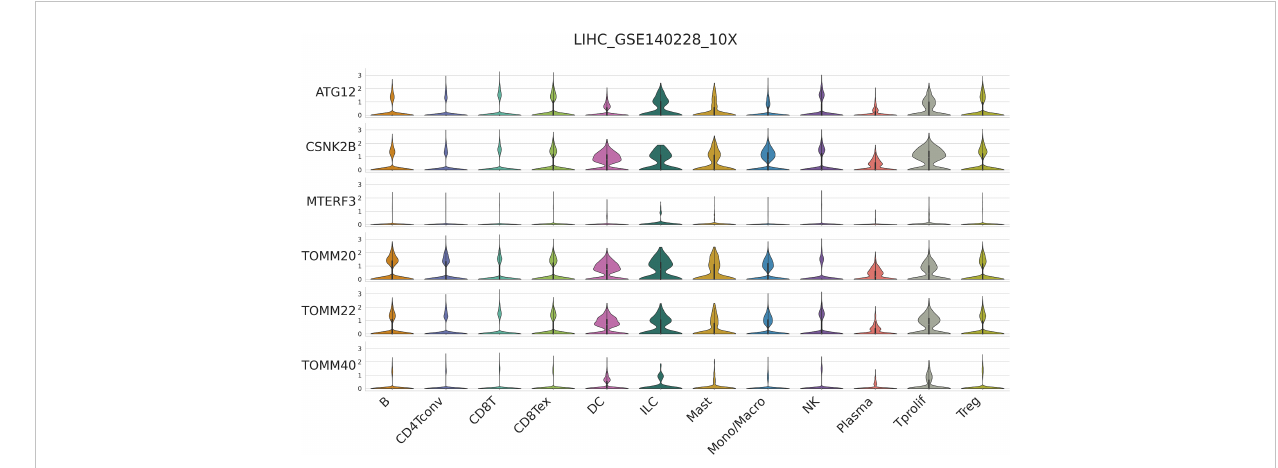
FIGURE 3 Single-cell RNA-seq analysis show the correlation between six mitophagy genes and the HCC Immune microenvironment by TISCH database.